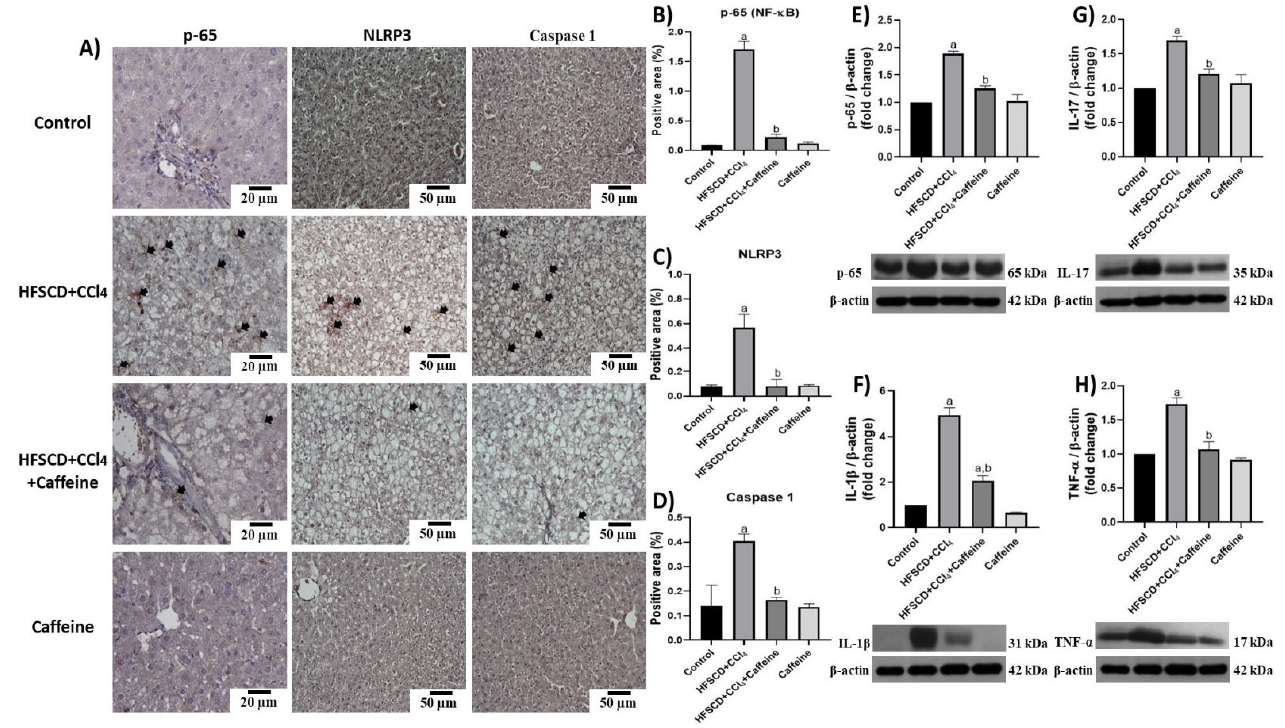
Figure 4. Effect of caffeine on NF ‐κ B (p65) level, proinflammatory cytokines, and NLRP3 of hepatic tissue from the NASH model. ( A ) Representative IHC images of p65, NLRP3, and caspase 1 of hepatic tissues from rats in the control, HFSCD+CCl 4 , HFSCD+CCl 4 +caffeine, and caffeine groups. Scale bar = 50 μ m and 20 μ m. Percentage of positive area for p65 ( B ), NLRP3 ( C ), and caspase 1 ( D ) obtained from IHC slices (n = 4). Arrows indicate a positive label. Levels of p65 ( E ), interleukin (IL) ‐ 1 β ( F ), IL ‐ 17 ( G ), and TNF ‐α ( H ). Proteins in hepatic tissues were detected using western blot analysis (n = 3). β‐ Actin was used as a loading control. Values are presented as fold increments in optical density normalized to control group values (control = 1). Bars represent the mean ± SEM. (a) p < 0.05 compared with the control group; (b) p < 0.05 compared with the HFSCD+CCl 4 group.